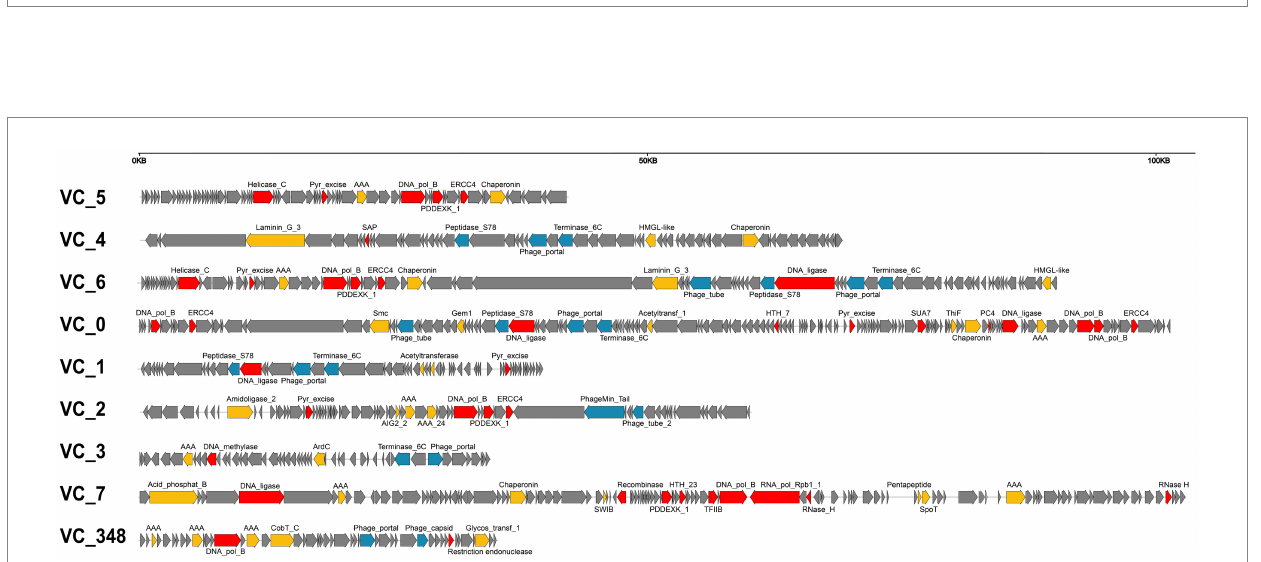
FIGURE 4 Summary of representative genome organization in different VCs of magroviruses. Different colors indicate genes with different functional categories: DNA metabolism genes are in red, structural genes are in blue, other functional genes are in yellow, and unclassified genes are in